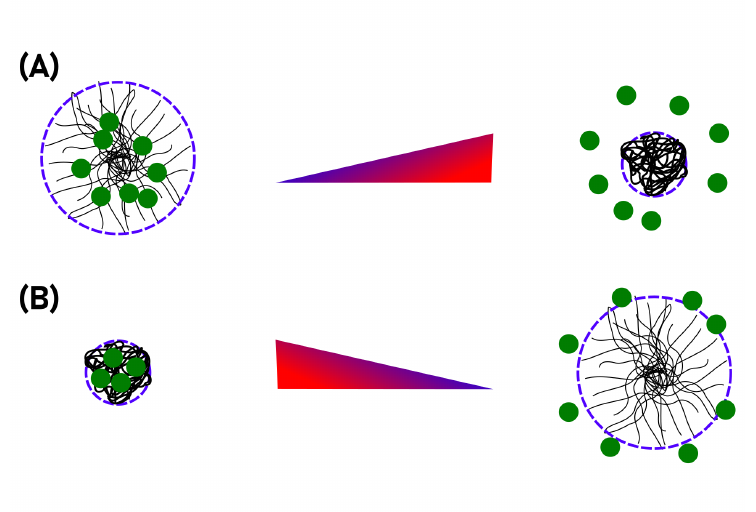
Figure 1. Two main concepts of microgel usage as drug carrier. In a hyperthermia treatment, the drug is loaded into the swollen gel and upon temperature increase it is pressed out of the polymer network alongside the solvent ( A ). Extremely hydrophobic substances may also be loaded in the collapsed state and released from the network into an hydrophobic environment upon swelling connected to a temperature decrease ( B